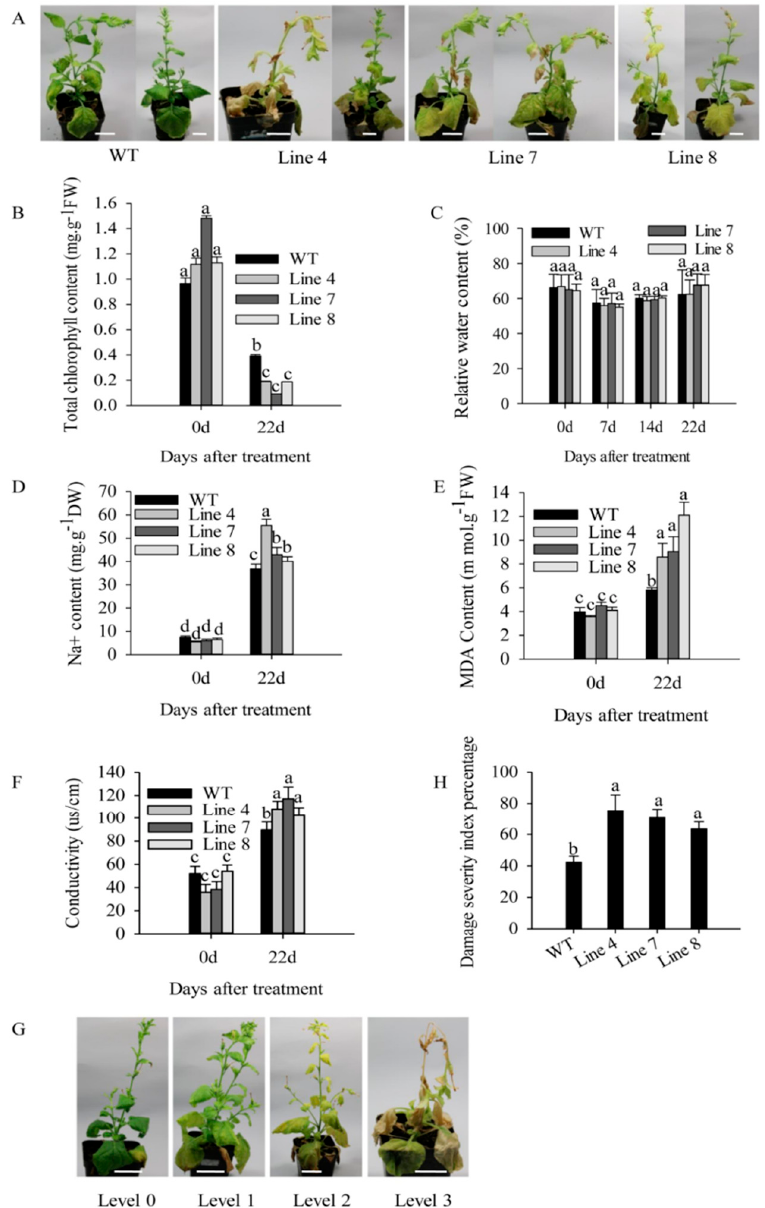
Figure 6. Overexpression of CaSBP12 in Nicotiana Benthamiana enhanced susceptibility to salt stress. ( A ) Phenotypes of transgenic (Line 4, Line 7 and Line 8) and wild-type lines after 22 days of treatment with 200 mM NaCl. ( B ) The total chlorophyll content of transgenic and wild-type lines after 22 days of treatment with 200 mM NaCl. ( C ) The relative water content of transgenic and wild-type lines during treatment with 200 mM NaCl at day 0, day 7, day 14, and day 22. ( D ) The Na + content of transgenic and wild-type lines after 22 days of treatment with 200 mM NaCl. ( E ) The MDA content of transgenic and wild-type lines after 22 days of treatment with 200 mM NaCl. ( F ) The conductivity of transgenic and wild-type lines after 22 days of treatment with 200 mM NaCl. ( G ) Classification of damage severity index percentage of transgenic and wild-type lines after 22 days of treatment with 200 mM NaCl. Level 0: no symptoms; Level 1: yellowing of lower leaves of plants; Level 2: the whole plant is yellowing and the edge of leaves is decolorized seriously; Level 3: whole plant yellowing and growth point death. ( H ) Damage severity index percentage of transgenic and wild-type lines after 22 days of treatment with 200 mM NaCl. The white line used as a scale bar (length 3.5 cm). Bars with different letters indicate significant differences at p ≤ 0.05. Mean values and SDs for three replicates are shown.